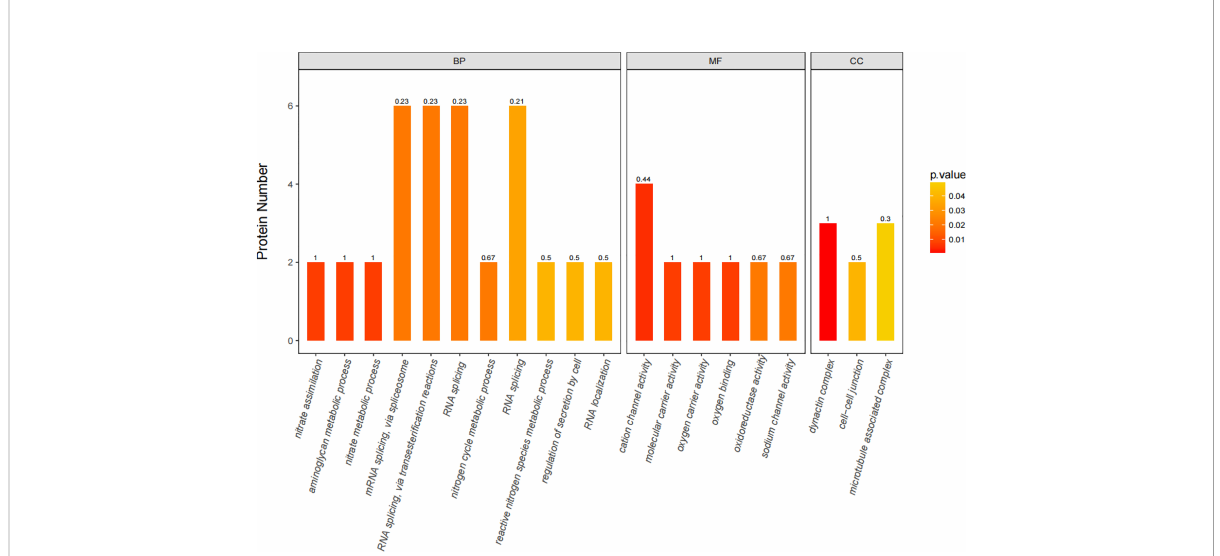
FIGURE 2 The 20 most signi fi cantly (p < 0.05) enriched GO terms based on differentially expressed proteins (DEPs) in SMC-treated sea cucumbers. GO enrichment for three ontologies (BP, biological process; MF, molecular function; CC, cellular component). The color bar shows the adjusted p - value calculated using Fisher ’ s exact test combined with Benjamini Hochberg ’ s correction. Rich Factor represents the ratio of the number of DEPs to the number of all annotated genes in this GO term, marked at the top of the bar